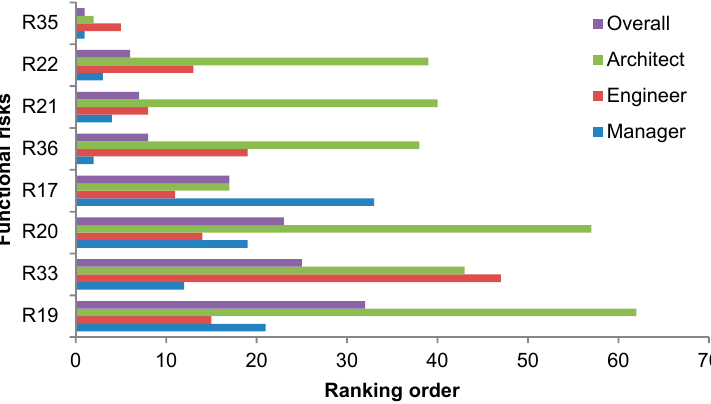
Figure 5. Ranking the functional risk factors impacting on the project value.